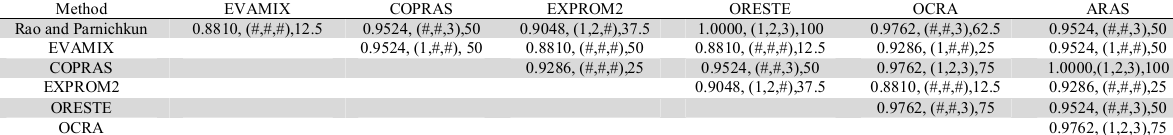
Performance test results of six preference ranking methods for example 2